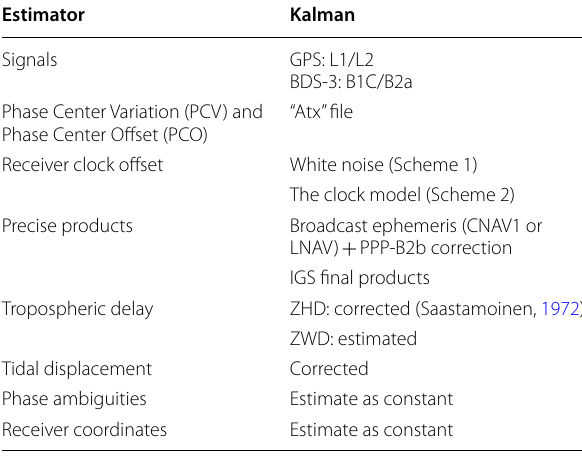
Table 1 Information on PPP time transfer with the